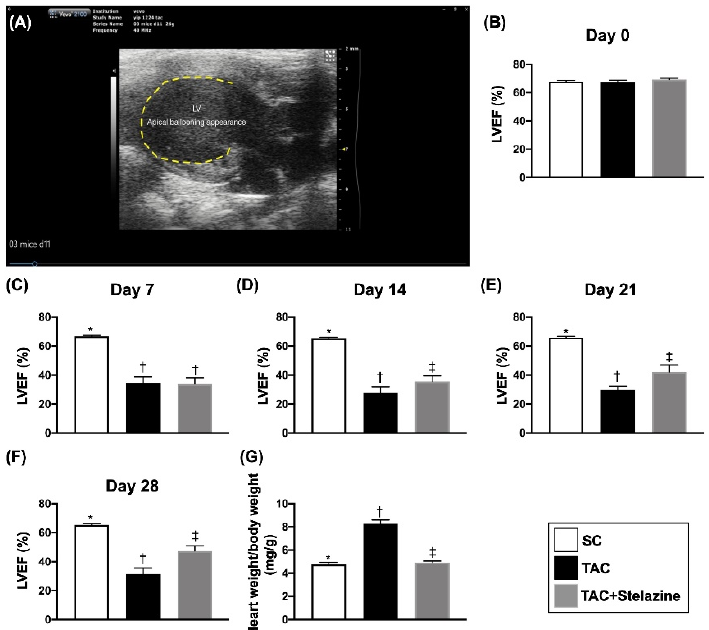
Figure 4. Illustrating the picture of apical ballooning, time courses of LVEF in B6 mice prior to and after TAC procedure, and day 28’s ratio of heart weight to body weight. ( A ) Illustrating the transaortic constriction (TAC) procedure successfully induced morphological feature of takotsubo cardiomyopathy (TCM) (i.e., apical ballooning) by day 14 after TAC procedure. The yellow dotted line indicated an apical aneurysm-like dilatation, mimicking TCM in an animal. ( B ) LVEF at day 0, p > 0.5. ( C ) LVEF at day 7 after TCA, * vs. †, p < 0.0001. ( D ) LVEF at day 15 after TCA, * vs. other groups with different symbols (†, ‡), p < 0.0001. ( E ) LVEF at day 21 after TAC, * vs. other groups with different symbols (†, ‡), p < 0.0001. ( F ) LVEF at day 28 after TAC, * vs. other groups with different symbols (†, ‡), p < 0.0001. ( G ) The ratio of heart weight to body weight by day 28 after the whole heart to be harvested. * vs. other groups with different symbols (†, ‡), p < 0.0001. All statistical analyses were performed by one-way ANOVA, followed by Bonferroni multiple comparison post-hoc test (n = 10 for each group). Symbols (*, †, ‡) indicate significance (at 0.05 level). SC = sham-operated control TAC = transverse aortic constriction; LVEF = left ventricular ejection fraction.